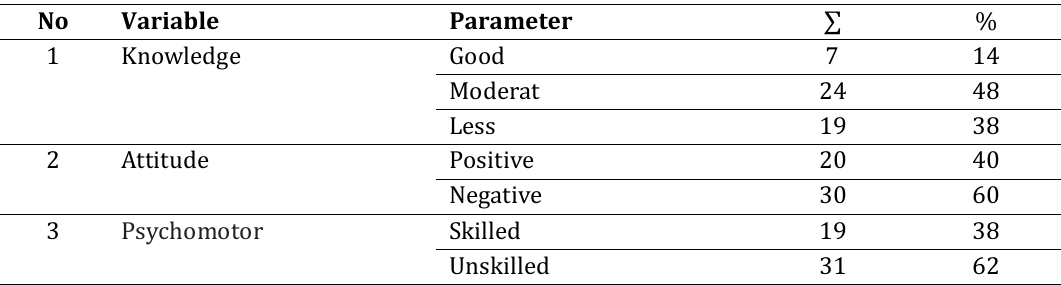
Evaluation of knowledge, attitude and psychomotor BLS of ER nurses